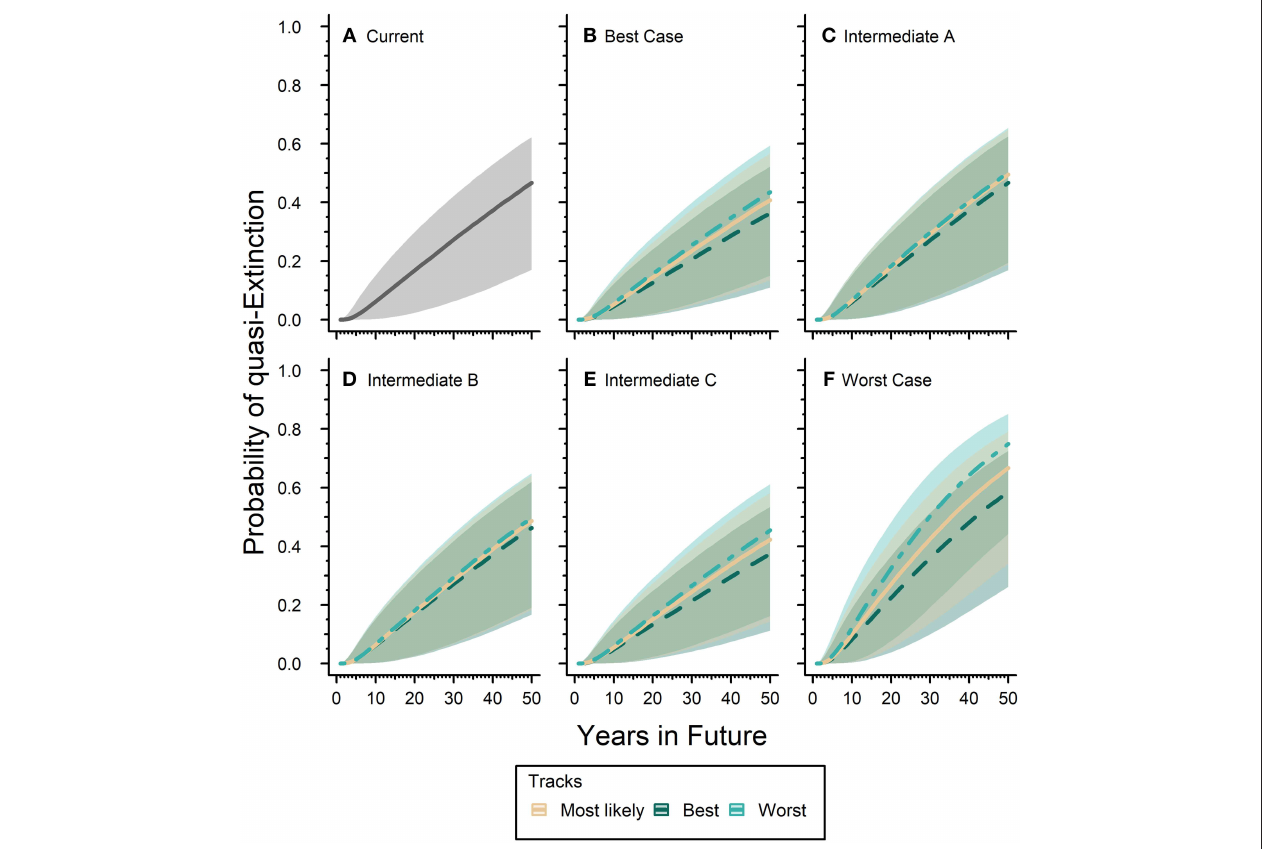
FIGURE 5 | Eastern monarch population future risk of quasi-extinction. Sub-figure (A) represents the “current” projected probability of quasi-extinction with only the effects of lambda and environmental stochasticity and no threats where the solid line is mean estimate and the gray ribbon is the associated 95% confidence interval. The remaining sub-figures (B–F) represent the projected probability of quasi-extinction under varying future scenarios that include population responses to threats. Sub-figures (B–F) contain three tracks for each scenario, which are represented by different line types and colors (see legend). Lines represent mean estimates and shaded ribbons are 95% confidence intervals. For all sub-figures the 95% confidence intervals cover the full range of quasi-extinction thresholds (0.05–0.61